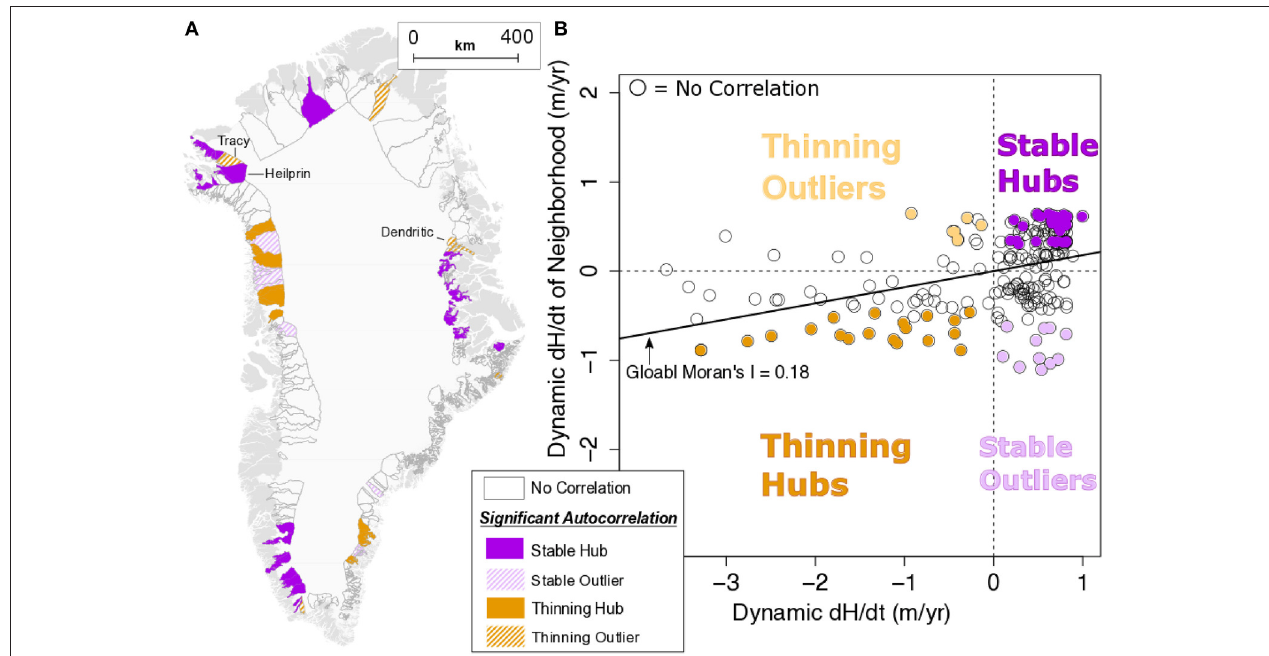
FIGURE 3 | (A) Glacier catchments with significant spatial autocorrelation from the LISA technique based on dynamic thinning rates from 2003 to 2009 (shown in Figure 1 ). Categories include hubs (solid) and outliers (striped) of both thinning and stable glaciers. Empty catchments show no significant spatial correlation. (B) Global Moran’s I scatterplot; standardized dynamic thinning rates for each glacier vs. their neighborhood’s weighted-mean thinning rate. Colors are the same as catchments in (A) .